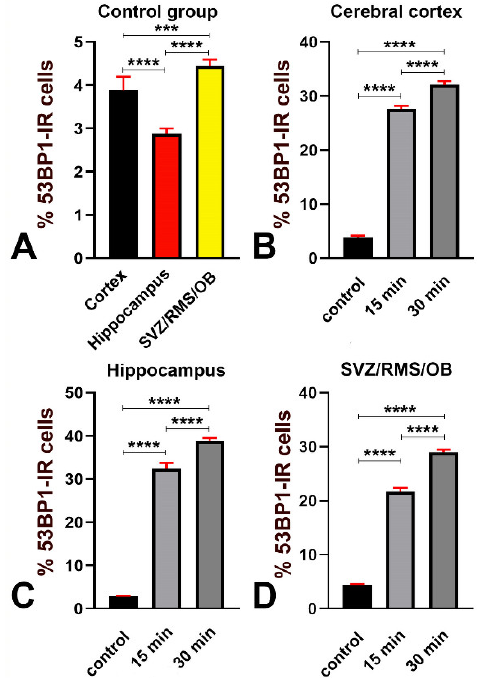
Figure A5. Percentage of 53BP1 immunoreactive cells versus the total number of cells in the forebrain ( A ), cerebral cortex ( B ), hippocampus ( C ), and SVZ/RMS/OB ( D ) of control, short-surviving, and long-surviving mice after nuclear labeling with DAPI. See Table A2 below for numerical data of statistics. Data are expressed as mean ± 95% CI. *** 0.001 > p ≥ 0.0001, **** p < 0.0001. Bars are 95% CI. Staining for γ H2AX was performed using the Upstate primary antibody. Table A2. Statistical analysis of volumetric densities of γ H2AX + 53BP1 double-labeled cells and percentages of 53BP1 immunoreactive cells. Legend : 1 = Welch’s ANOVA and Dunnett’s T3 multiple comparison test; 2 = Ordinary one-way ANOVA and Tukey’s multiple comparisons test. See Figure 6 for